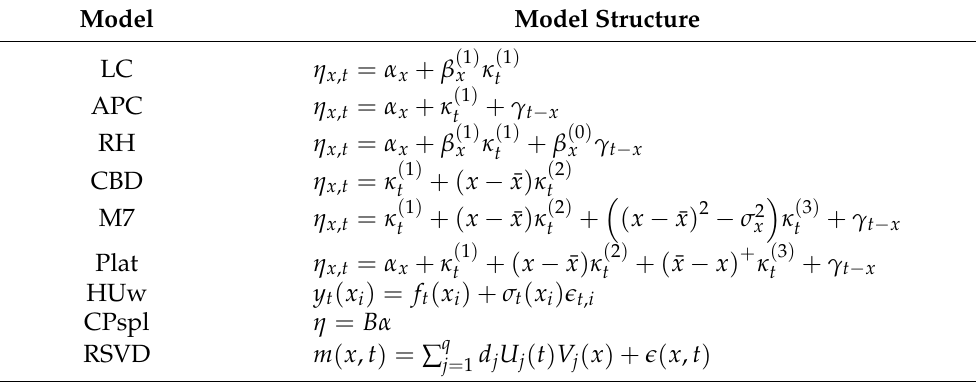
Table 1. Stochastic mortality model